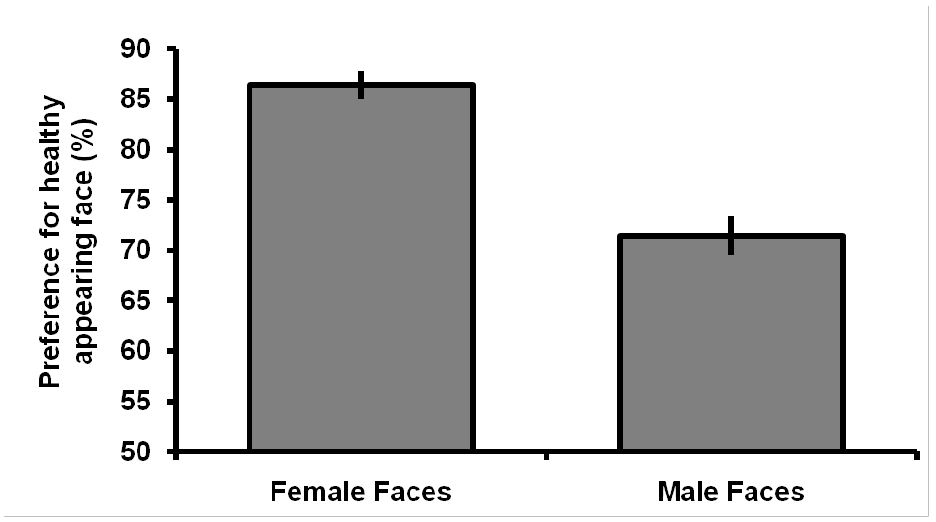
Figure 2 . Preferences for healthy appearance in female faces (top) and male faces (bottom) (±1SEM).